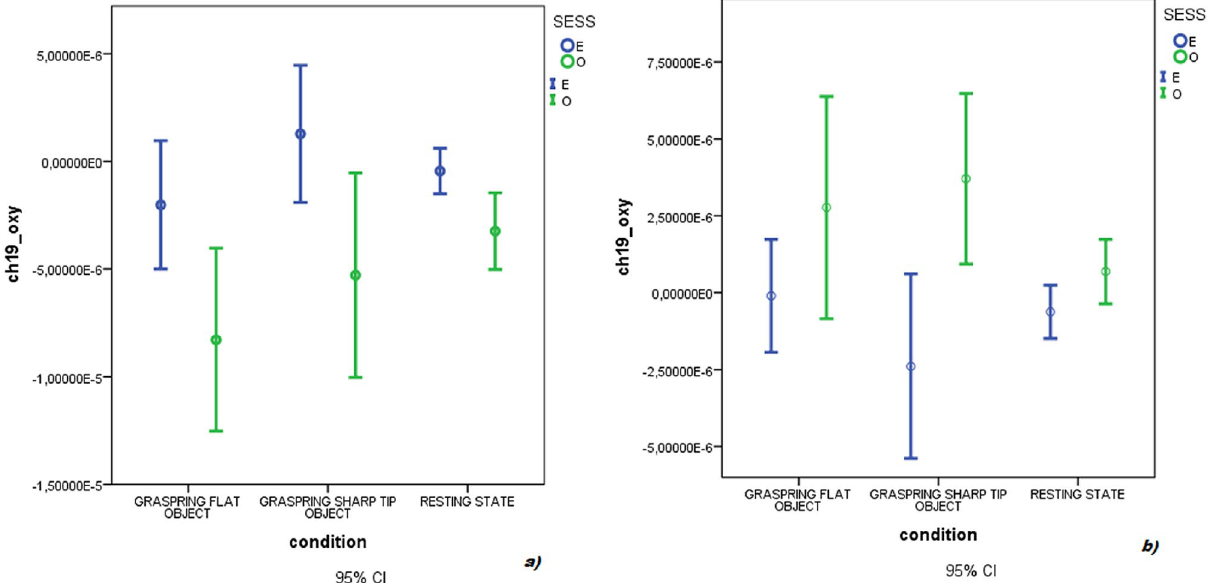
Figure 9. Mean and 95% CI of oxyhemoglobin level in a representative channel (19) in controls ( a ) and FM patients ( b ). During the Time-to-contact detection task, oxyhemoglobin increased in controls and decreased in FM. In FM patients, the decrease of oxyhemoglobin level during this session was specifically present during sharp tip object